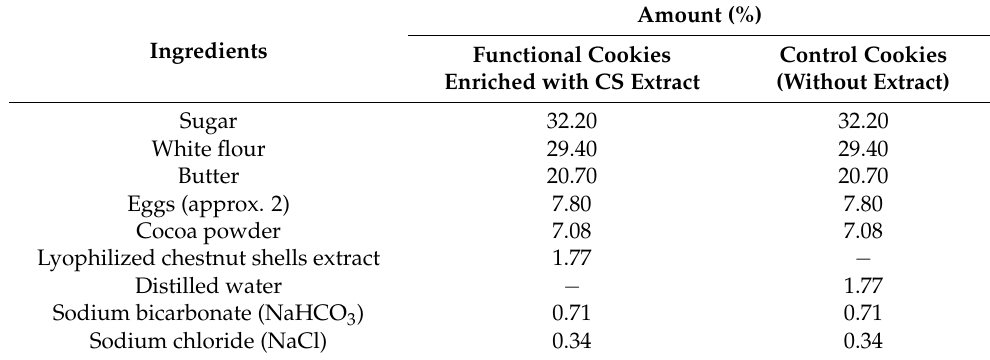
Table 1. Formulation of functional cookies enriched with chestnut shells extract prepared by SWE and control cookies (without